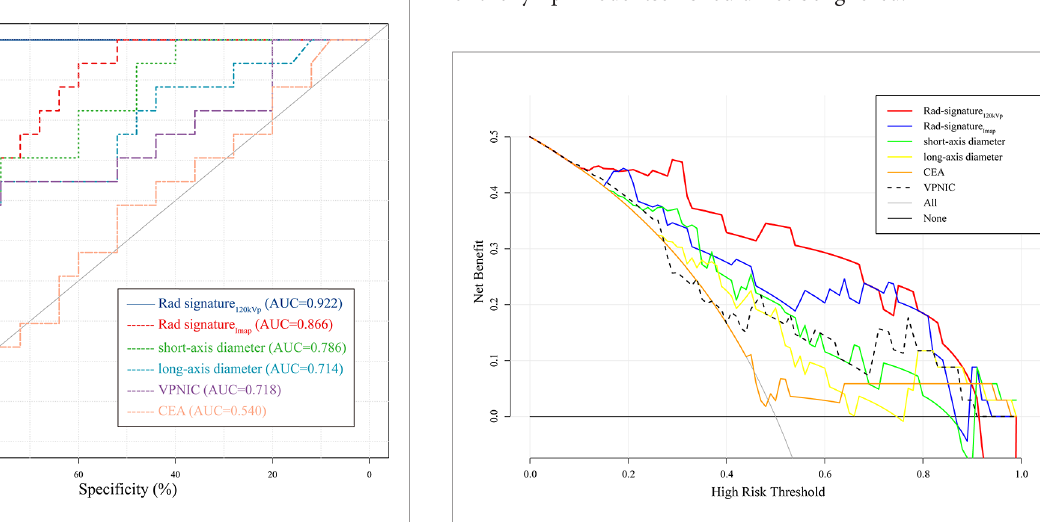
FIGURE 8 | Decision curve of 6 different signatures or indicators in the testing cohort. The 120kVp-like radiomics signature had the highest area under Curve (AUC) in the majority range of risk thresholds. Only the curve of DECT quantitative parameter with the highest AUC was drawn to improve readability. VPNIC: venous phase normalized iodine